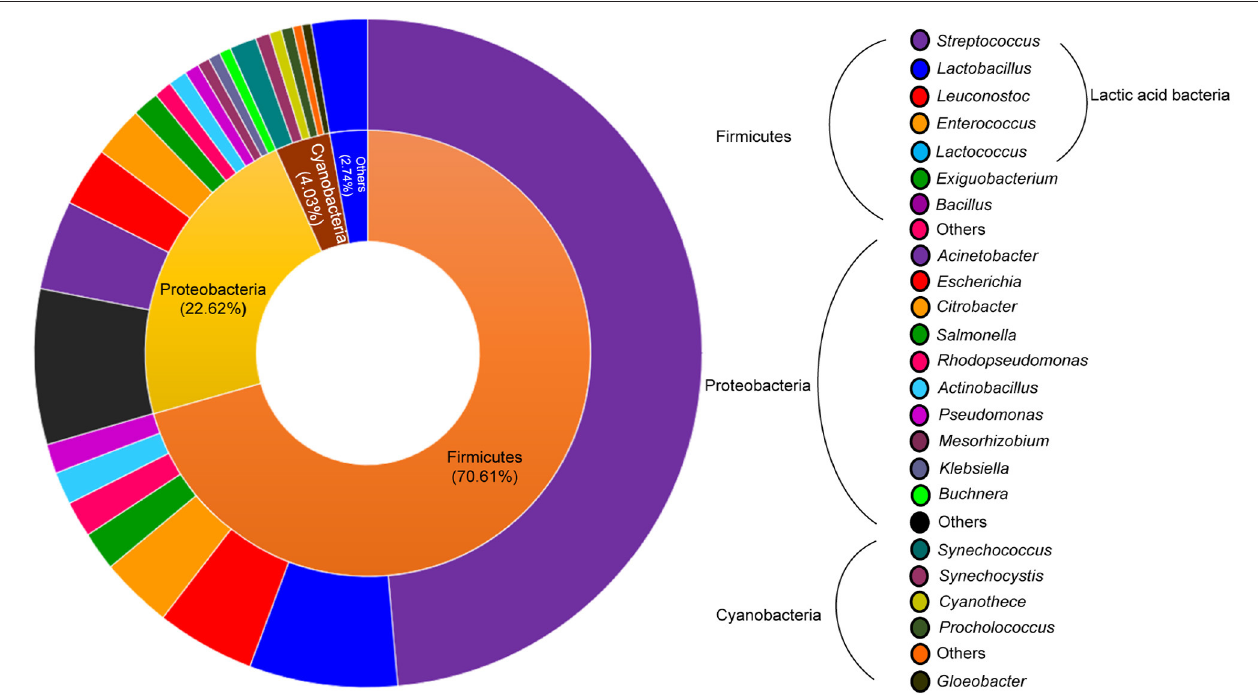
FIGURE 2 | Donut plots representing the bacterial population in all pozol fermentation process. The inner and outer circles show the percentage distribution of the proteins at phylum and genus level, respectively.